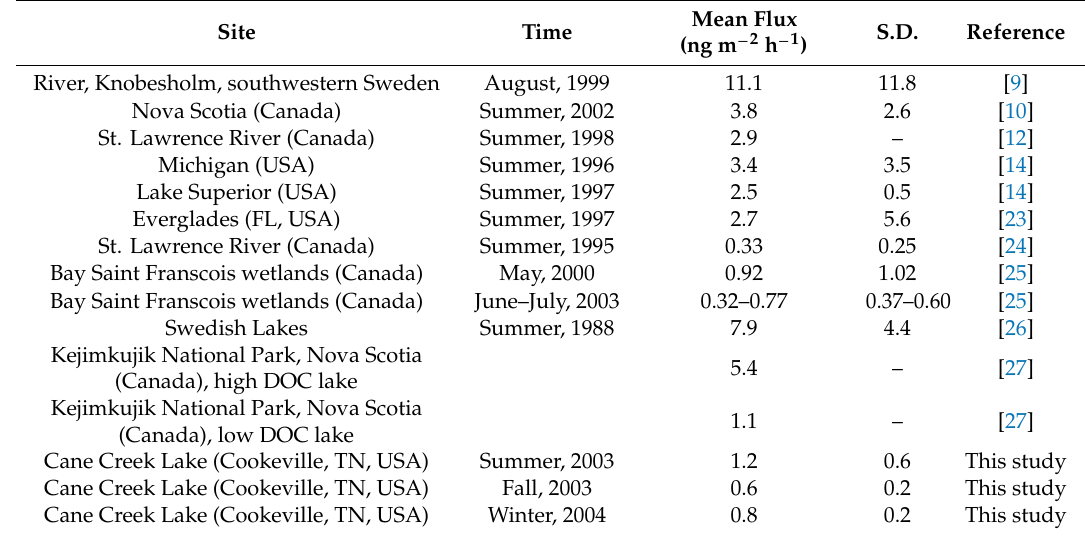
Table 1. Summary of some published data of the Hg air / water exchange fluxes obtained over various natural fresh water systems using the dynamic flux chamber (DFC)